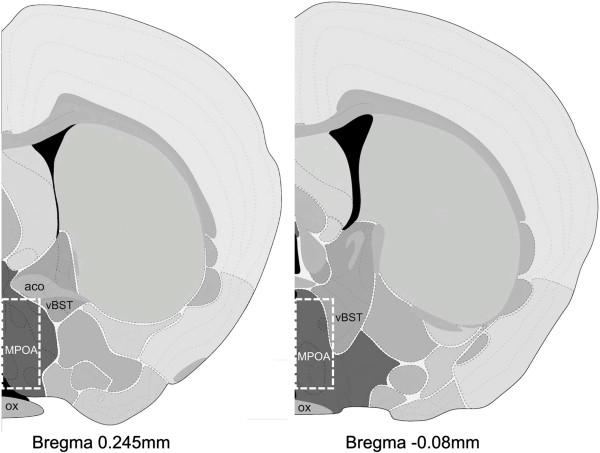
Representation of the region collected (white boxed area) for microarray and qPCR analysis. MPOA was collected from approximately Bregma 0.245 mm to -0.08 mm. Images were modified from The Allen Mouse Brain Atlas (coronal sections, version 1, 2008). aco: anterior commissure; MPOA: medial preoptic area; ox: optic tract; vBST: ventral bed nucleus of the stria terminalis.